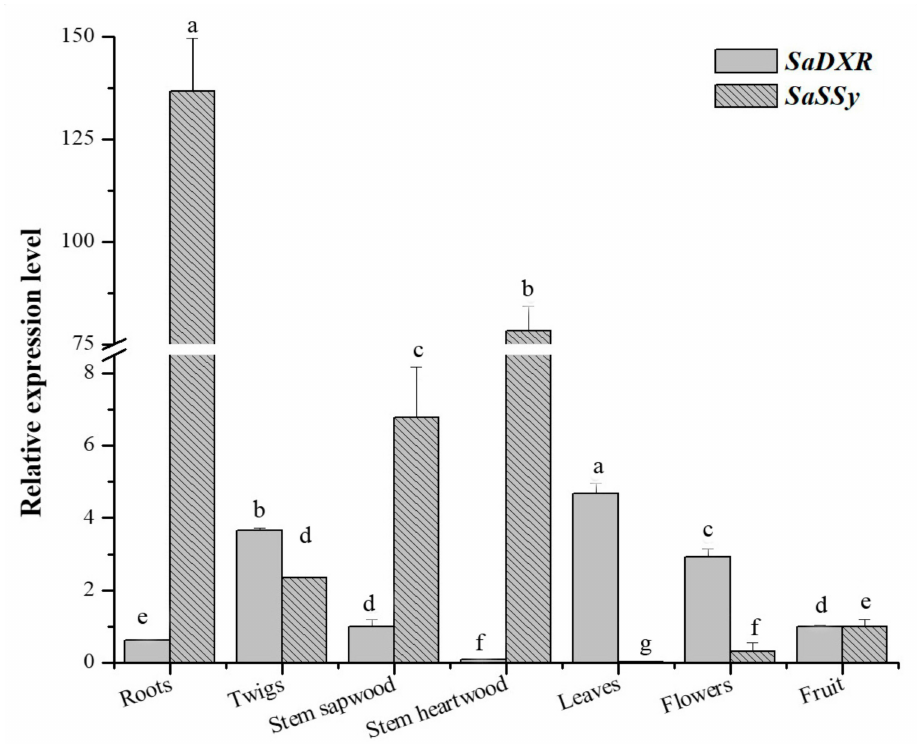
Figure 6. Expression patterns of SaDXR and SaSSy in different organs of a 7-year-old S. album trees analyzed by qRT-PCR. Each value represents the means of three independent biological replicates ± SD. Different letters (a,b,c,d,e,f,g) above bars indicate significant differences among organs, assessed separately for SaDXR and SaSSy (DMRT, p <